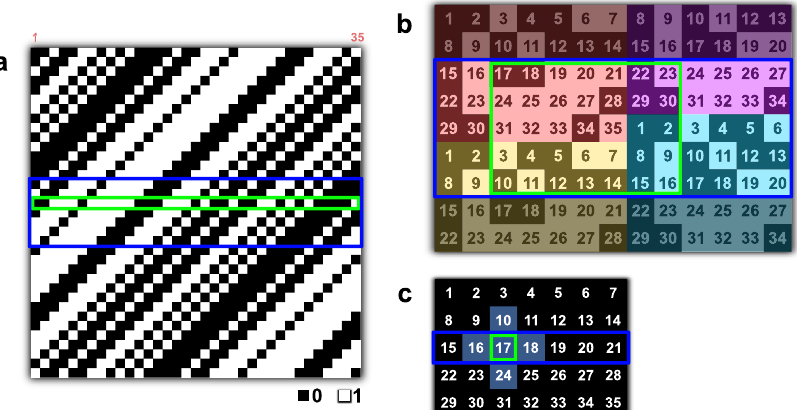
Fig. 2 | Coding strategy of SPI-ASAP. a Binary cyclic S-matrix of order n = 35 (i.e., p =7 and q =5). Green boxes (also appearing in ( b ) and ( c )) highlight the role of a single encoding pattern. Purple boxes (also appearing in ( b ) and ( c )) highlight a range of p rows deployed together in each scan. b Restructured matrix pattern formed from the matrix shown in ( a ). The numbers represent the corresponding column indices of each element of the fi rst row of the matrix shown in ( a ), with shadedcolorshighlightingfourtiledcopiesofthereshapedinitialrow.Thepurple- boxed region shows an aggregate pattern that is displayed via DMD. The green-